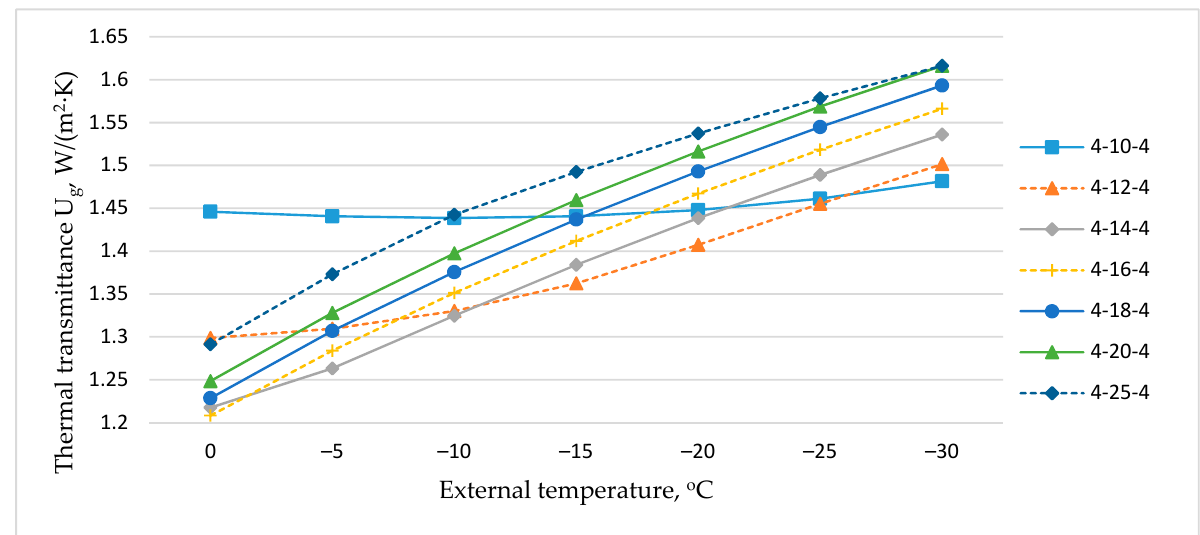
11 of 18 Figure 4. Dependence of the U g -value of a double-glazed IGU on the distance between the panes and external air temperature. The dependencies of the thermal transmittance (U g , W/(m 2 · K)) values of the central part of the double-glazed IGU on the external air temperature and concentration of argon gas fill, when the Low-E coating’s corrected emissivity value was ε = 0.04 and the distance between glasses was 16 mm, are given in Figure 5. The results show that the changes in the concentration of the argon gas fill did not change the dependence tendency of the thermal transmittance value on the external air temperature.